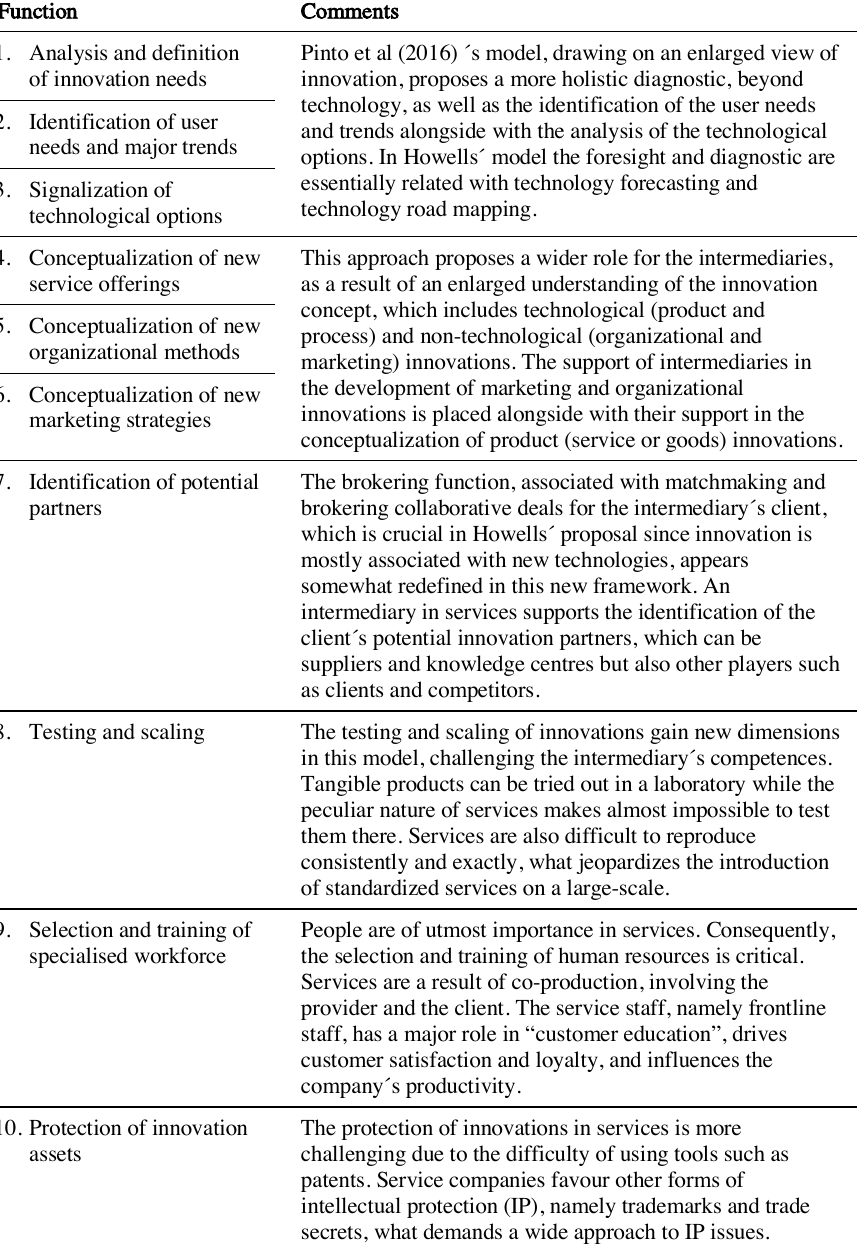
Table 1. Functions of innovation intermediaries proposed by Pinto et al (2016): Critical analysis